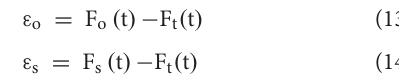
FIGURE 7 | Comparison of random AquaCrop simulated yield and the corresponding statistical